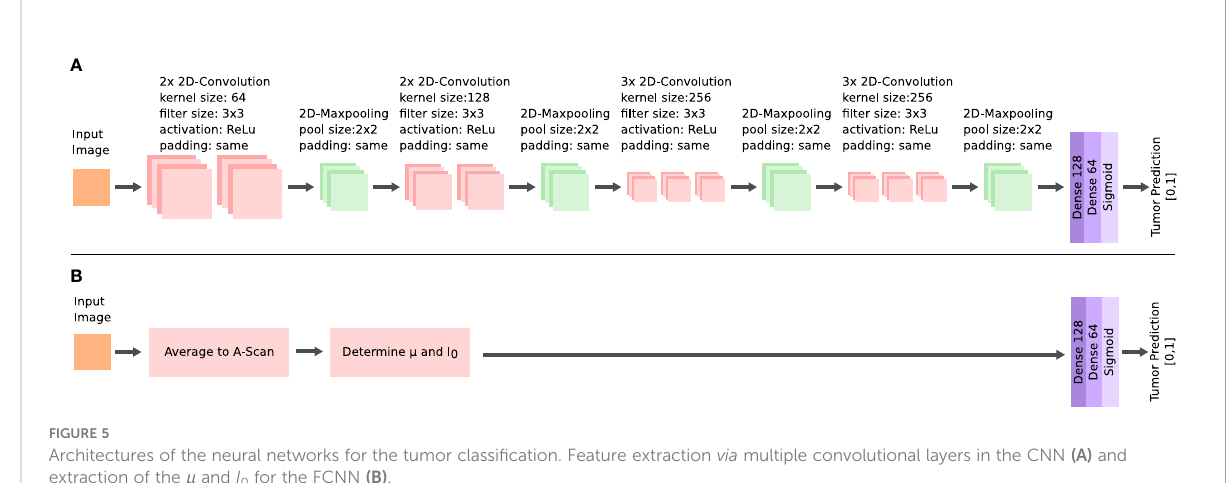
FIGURE 5 Architectures of the neural networks for the tumor classi fi cation. Feature extraction via multiple convolutional layers in the CNN (A) and extraction of the m and I 0 for the FCNN (B)